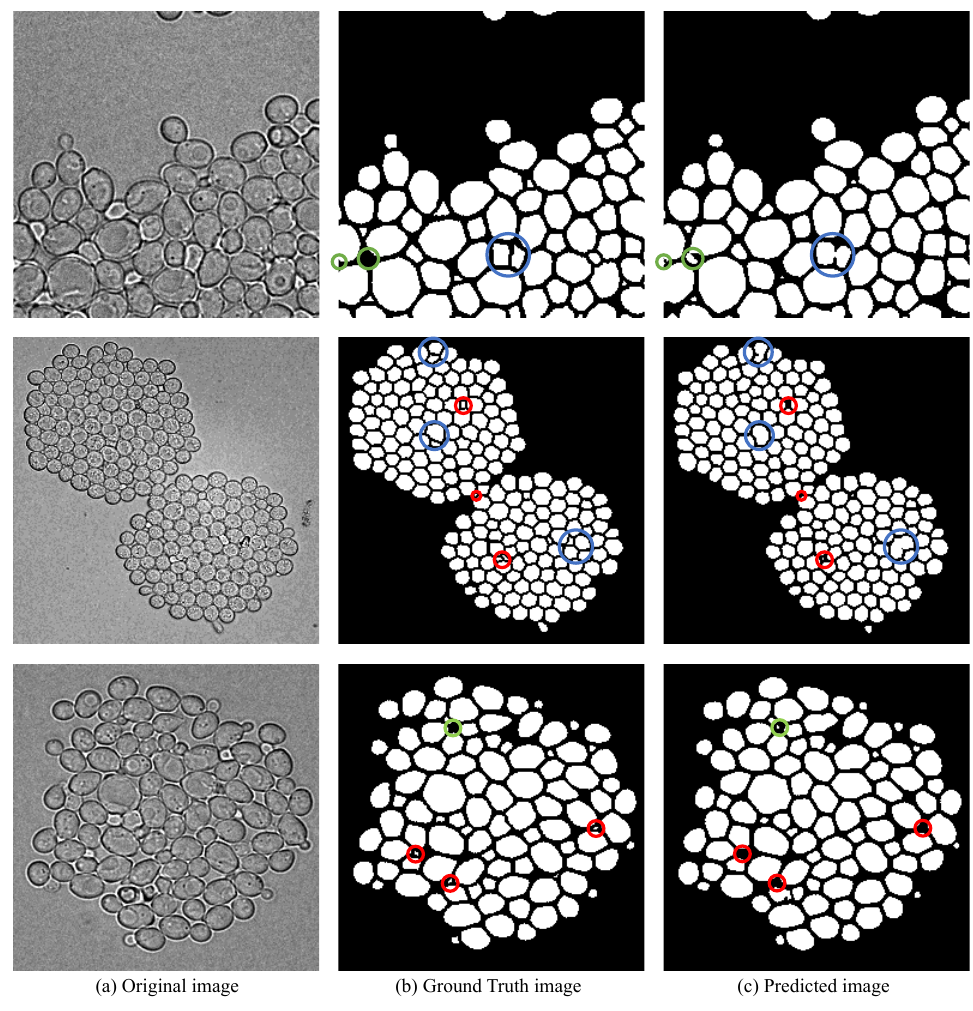
Figure 10. An example of incorrect segmentation results using the proposed PID-Net. The situations of adherent yeast cells and mis-segmentation lead to counting